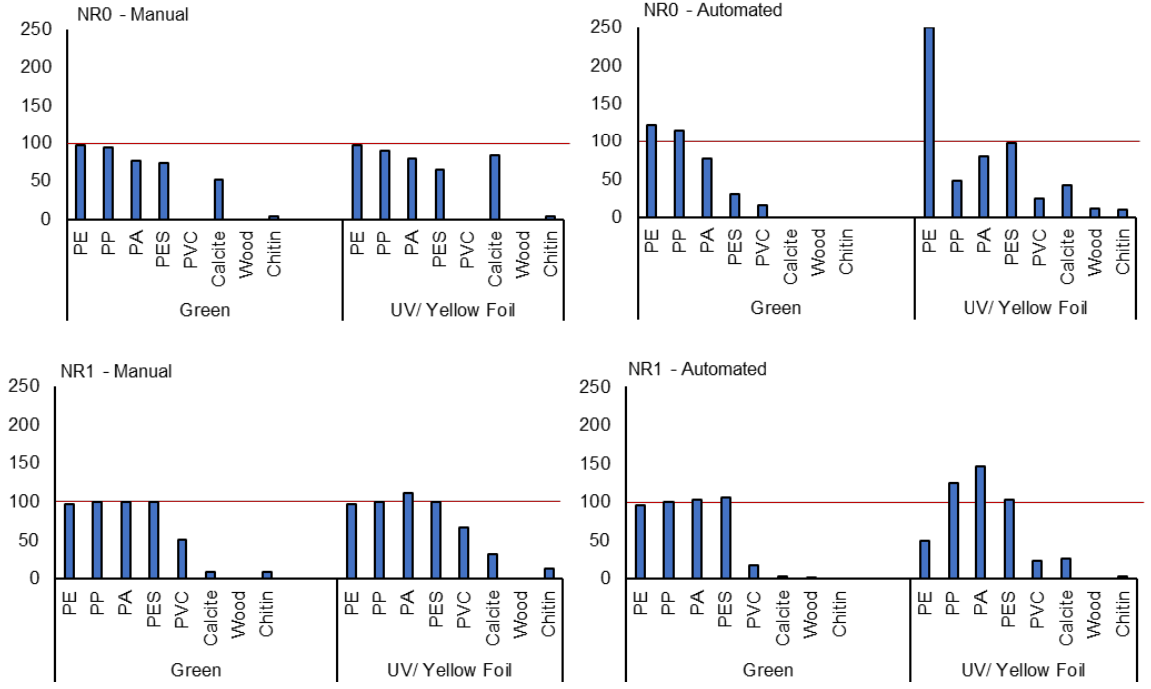
Figure 8. Measured recovery rates of microplastic and natural particles stained with Nile red (NR0, 1 mg/L) and the newly developed derivatives NR1 (1 mg/L). Green fluorescence: Ex: 420 – 470 nm; Em: 500 – 570 nm; yellow colored foil: Ex: UV-Lamp, Peak 365 nm; Em: Figure S1. When comparing the results between the green fluorescence and the yellow color foil